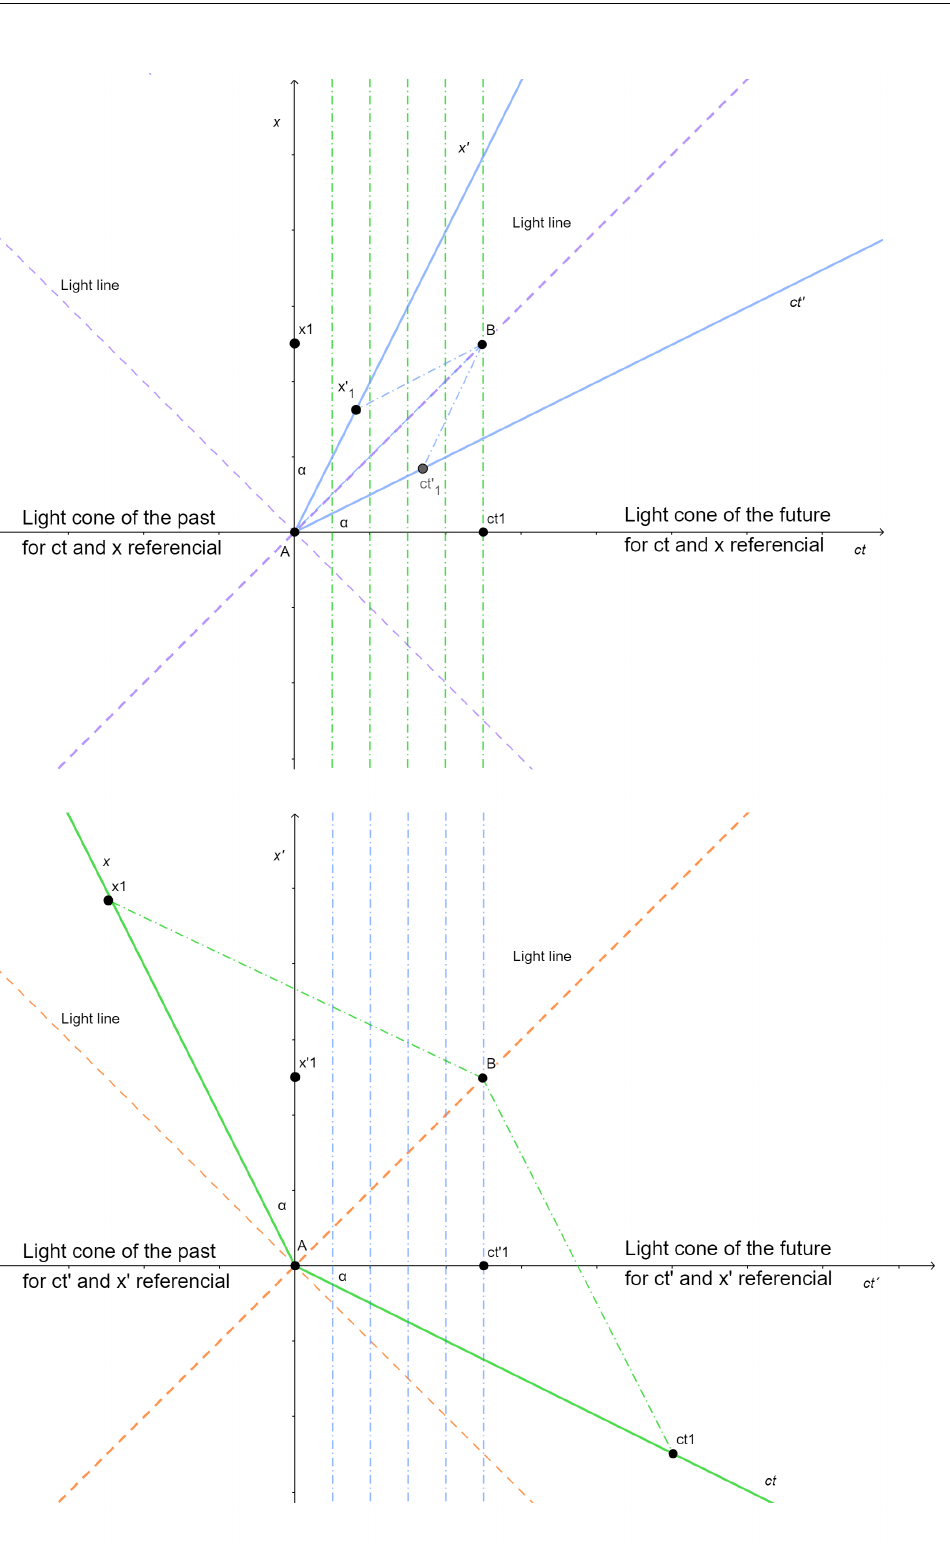
Figure 2. L ( top image ) and L (cid:48) ( bottom image ) spacetime